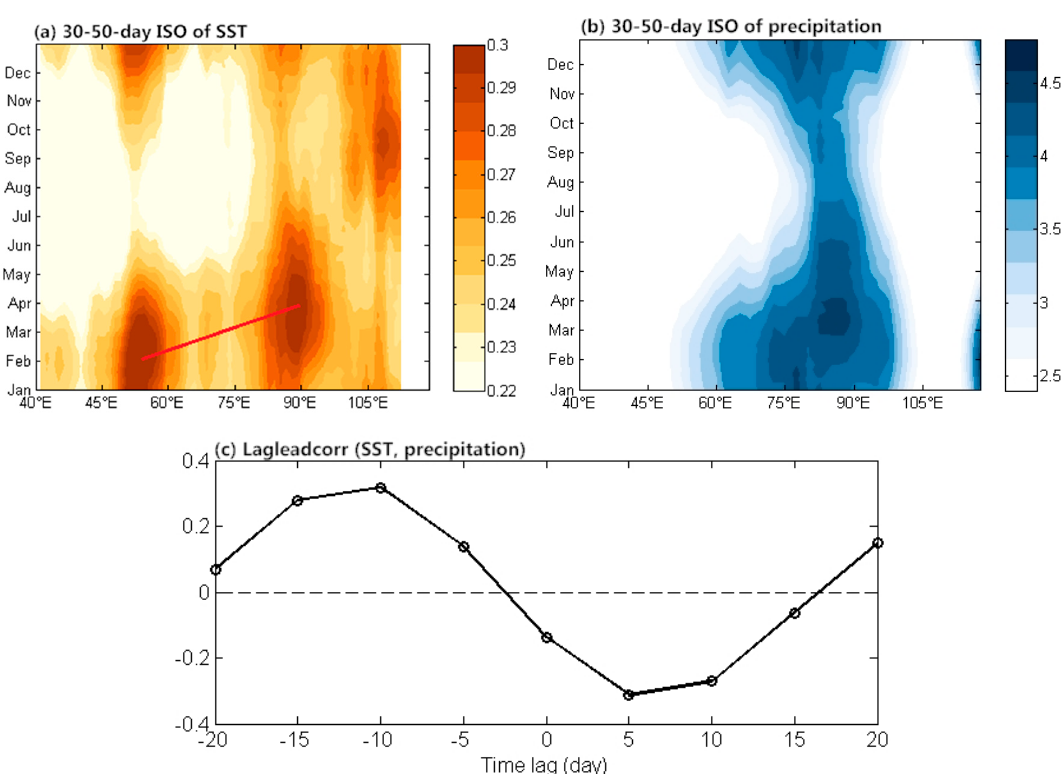
Figure 7. Hovmöller diagrams of RMS variance of 30–50-day: ( a ) SST ( ◦ C); and ( b ) precipitation (mm/day) anomaly averaged in 6–12 ◦ S. The red line in ( a ) indicates the approximation of maximum 30–50-day SST variability. ( c ) Lag correlations of 30–50-day SST with precipitation anomaly averaged in A. SST leads precipitation at negative lags. The statistical significance of correlation is assessed by student- t test. The effective DOF is 1070 with the sample number of 2555, and the correlation is 95% significant at a minimal value.